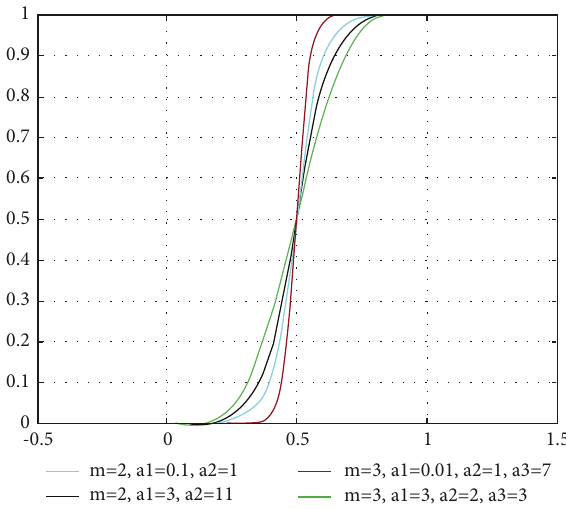
Figure 2: The image of four groups of sigmoid